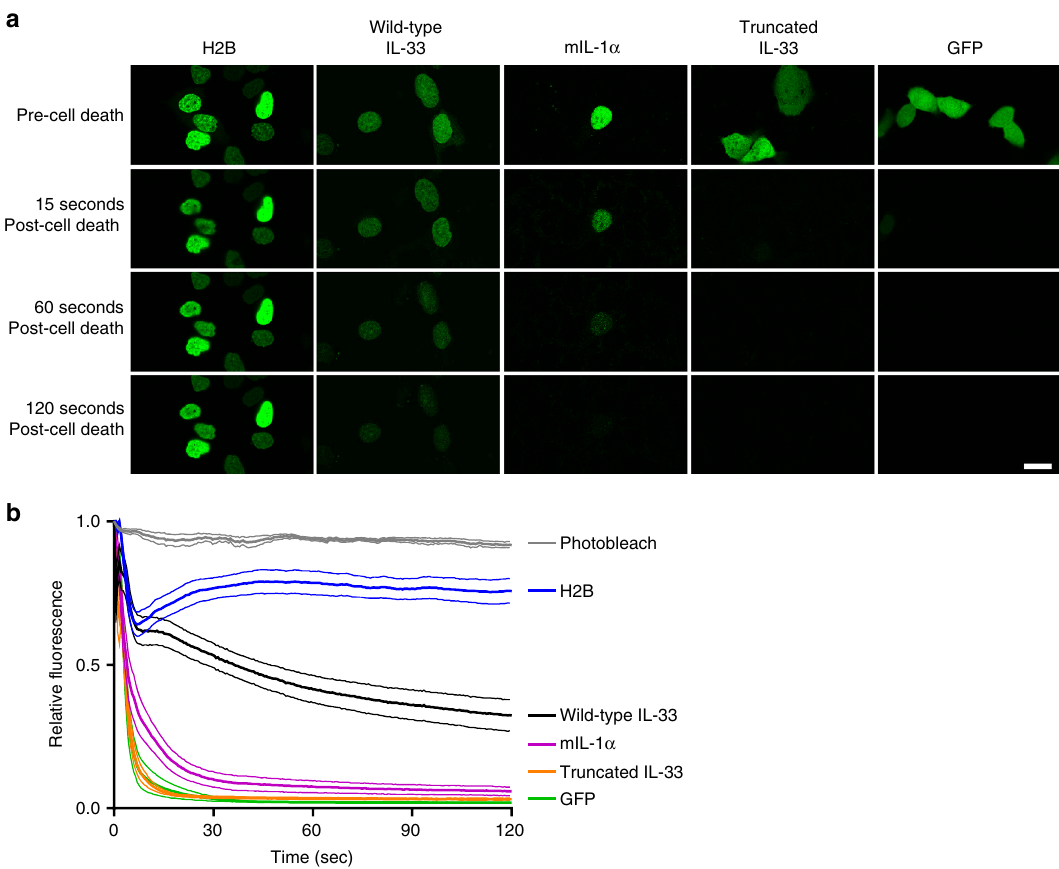
Fig. 6 Chromatin-binding dynamics regulate IL-33 release kinetics. a TE-7 cells were transiently transfected with plasmid encoding the indicated GFP- fusion protein and then treated with Triton X-100 (0.13%) to induce necrosis. Depicted are images from a representative experiment showing 5 s prior to cell killing by the Triton X-100 ( “ Pre-Cell Death ” ; top row) and 15, 60, and 120 s after death ( “ Post-Cell Death ” ; second, third, and fourth rows, respectively) from a representative experiment. Scale bar is 10 μ m. b Quanti fi cation of intracellular fl uorescence intensity from three combined independent experiments. Data are normalized to time zero, which is when Triton X-100 was added. Photobleach curve was generated in the absence of Triton X-100. For each depicted curve, the central, thicker line indicates the mean and the bordering, thinner lines of the same color indicate the standard error of the mean. GFP: green fl uorescent protein, IL: interleukin, mIL-1 α : mouse IL-1 α